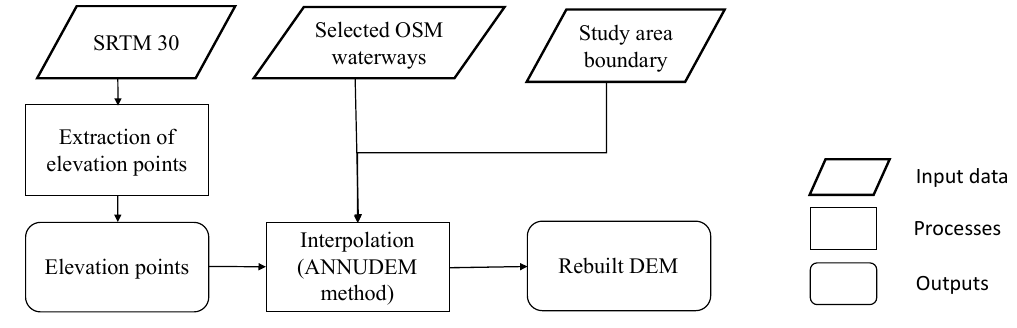
Figure 11. Flowchart of processes to create the rebuilt DEM.